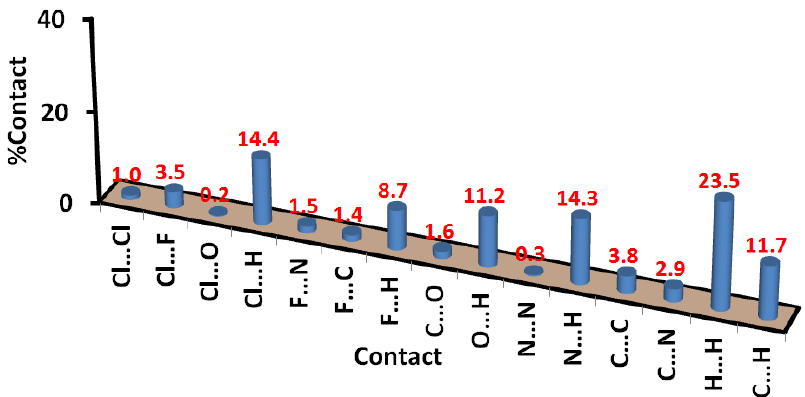
Figure 7. Percentages of intermolecular interactions in 3 .